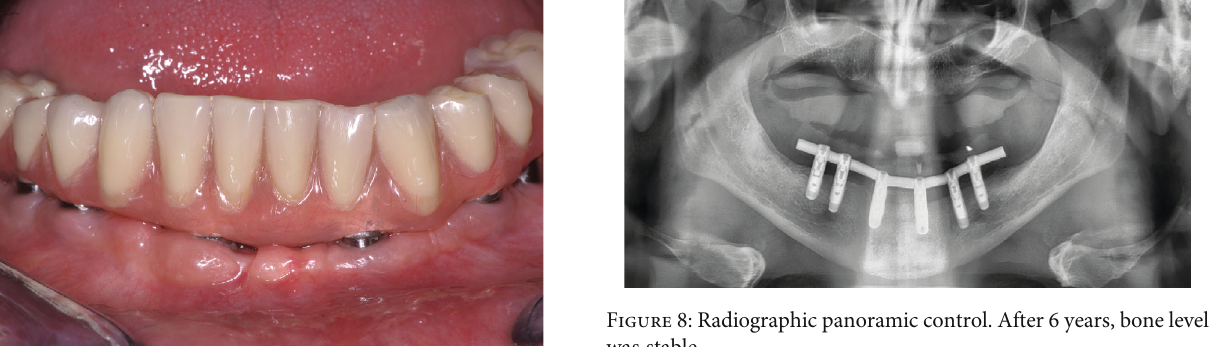
Figure 7: Final prosthesis. The molars and cantilevers were in occlusion, and a new adaptation to the crest was performed. The peri-implant tissues appeared healthy, indicating good oral hygiene level maintenance.